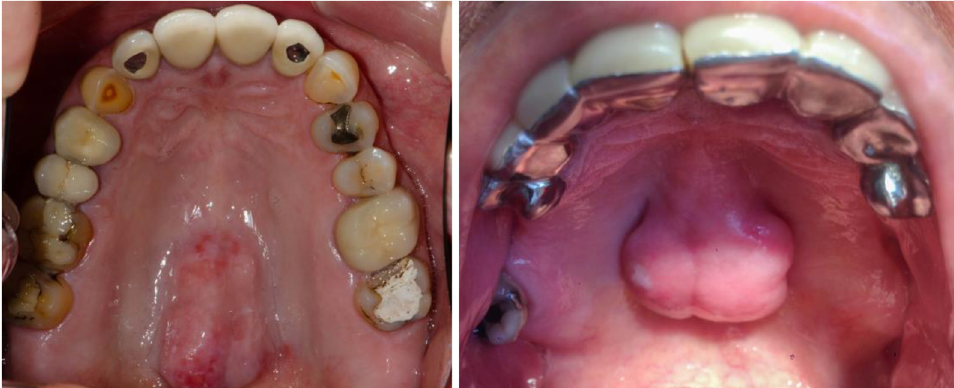
Fig. 1. Palatal tori. (a) Palatal torus located in the posterior third of the hard palate with multiple erosive traumatic ranges (patient T). (b) Palatal torus located in the median third of the hard palate.